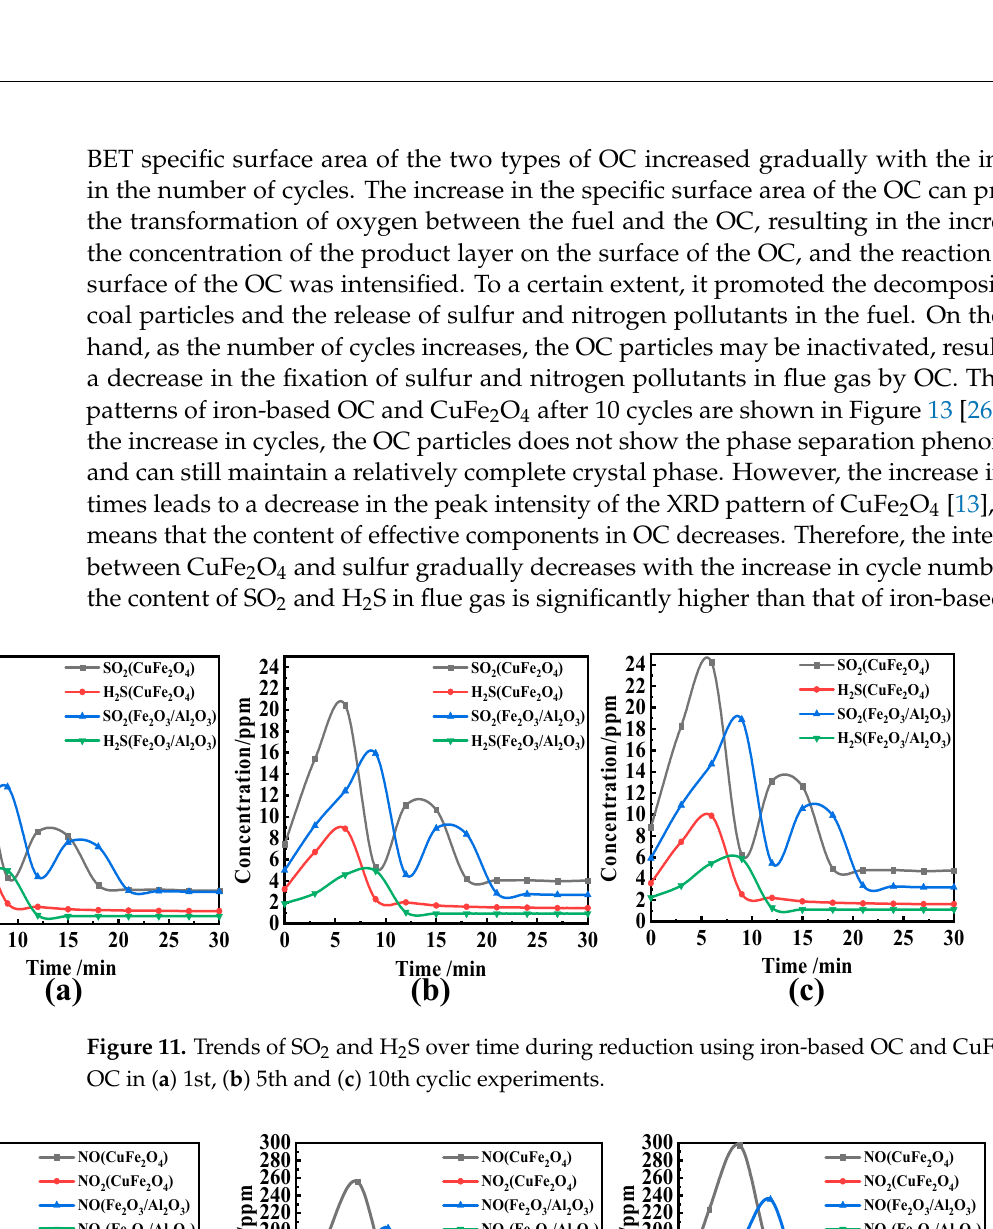
10 of 14 Figure 10. XRD patterns of ( a ) Fe 2 O 3 /Al 2 O 3 and ( b ) CuFe 2 O 4 at different reaction temperatures. 3.3. Transformation and Migrant Behavior of Sulfur and Nitrogen in Cyclic Experiment In this section, the effects of O/C and reaction temperature on the migration and